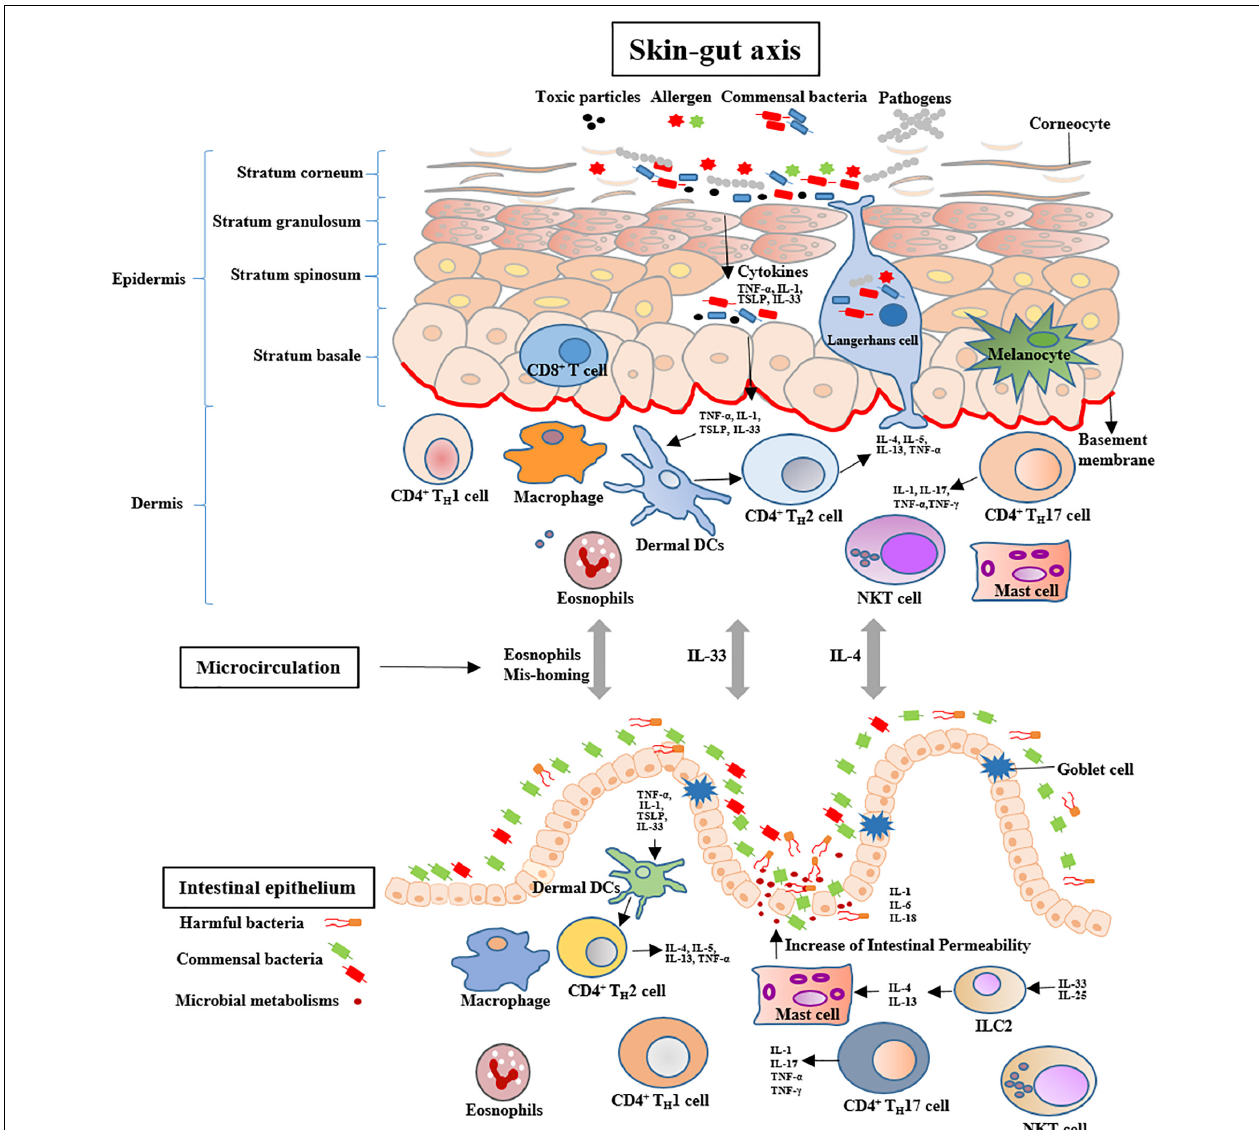
FIGURE 2 | Potential mechanisms of skin-gut cross talk include increases in the number of intestinal MCs and skin-originating eosinophils mis-homing. Systemic IL-4 may activate the intestinal MCs to increase the permeability of the gut. Systemic IL-33 may increase the number of mucosal MCs in the small intestine via ILC2 activation. MCs = Mast cells; IL-4 = Interleukin-4; ILC2 = Type 2 innate lymphoid